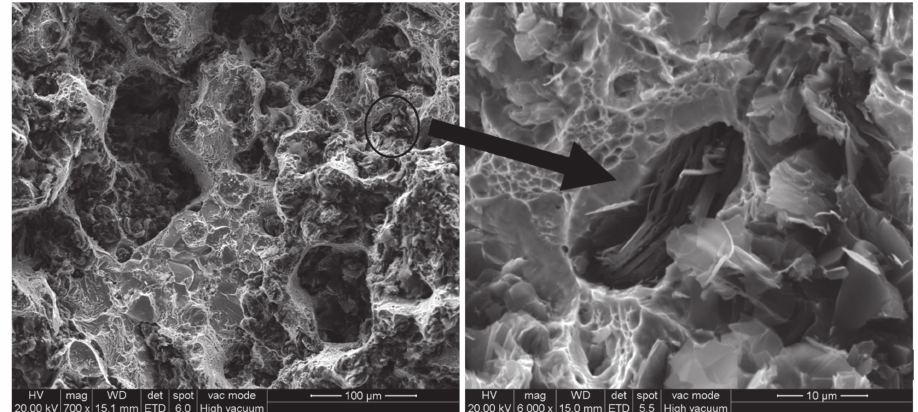
Figure 5. SEM Images of CG breakage caused in a Charpy impact